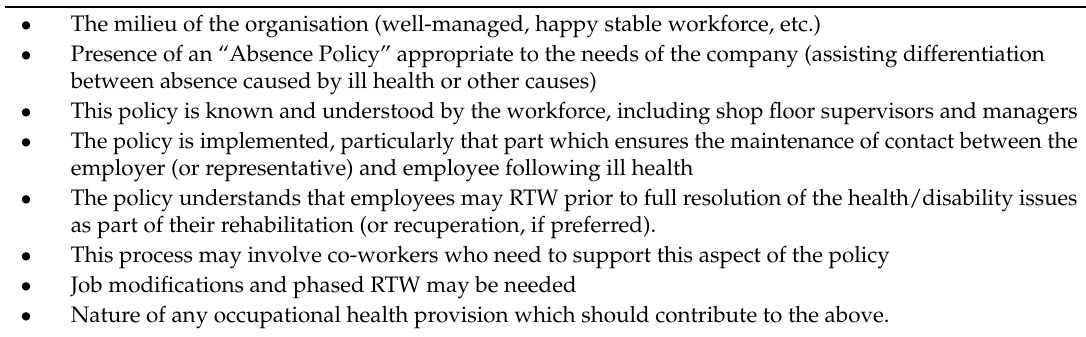
Table 1. Employer’s influence on job